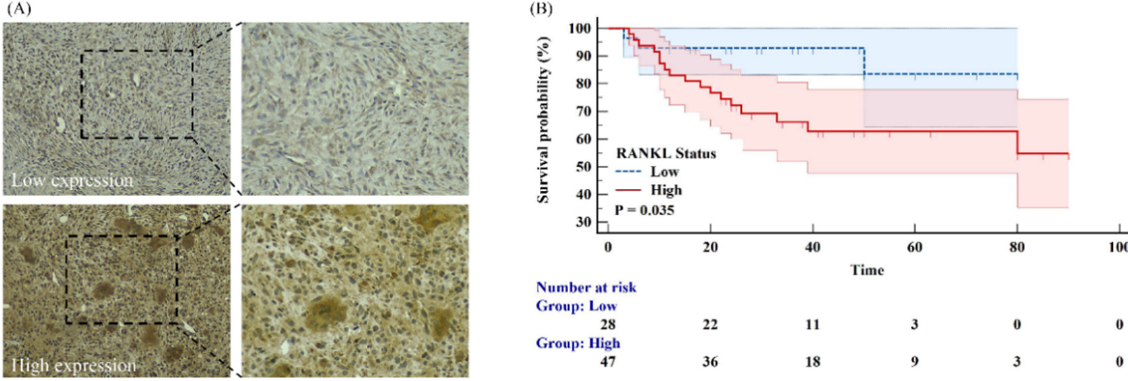
Figure 5. ( A ) Immunohistochemical staining of RANKL in spinal GCTB. Original amplification: 200×. ( B ) Kaplan-Meier survival analysis of the impact of RANKL status.